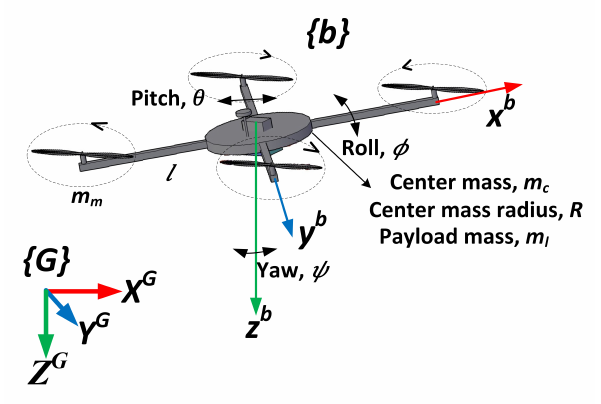
Figure 1. The main components of